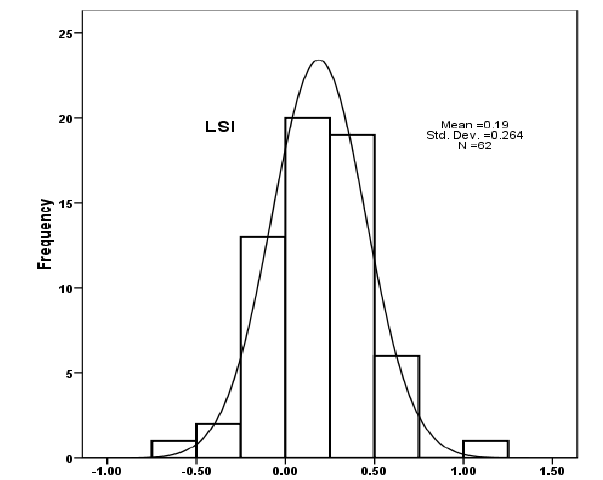
Figure 2. Data histogram of Langelier saturation index